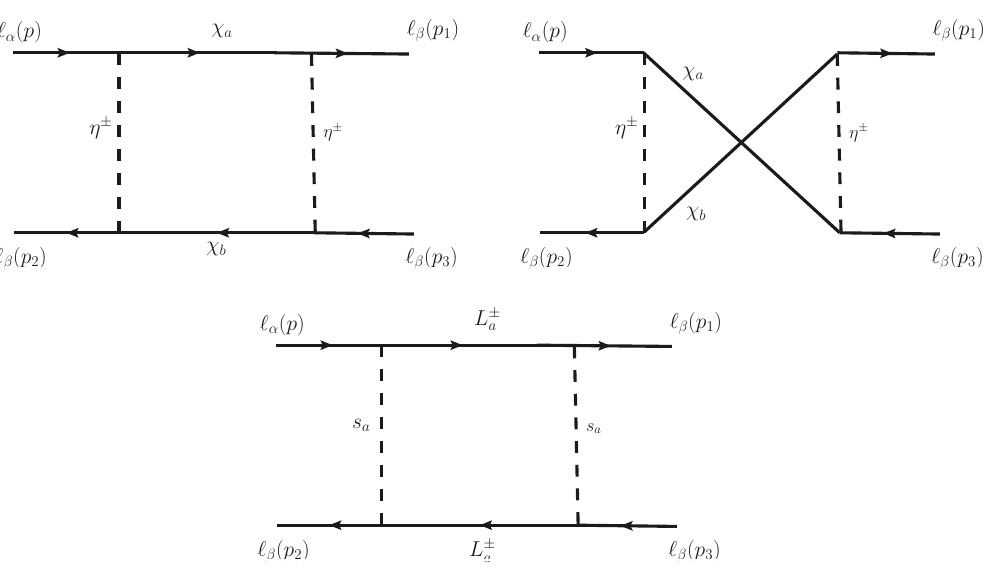
decay. As before, a, b = 1 , 2 (for L ± → ‘ − ‘ − ‘ + α β β β